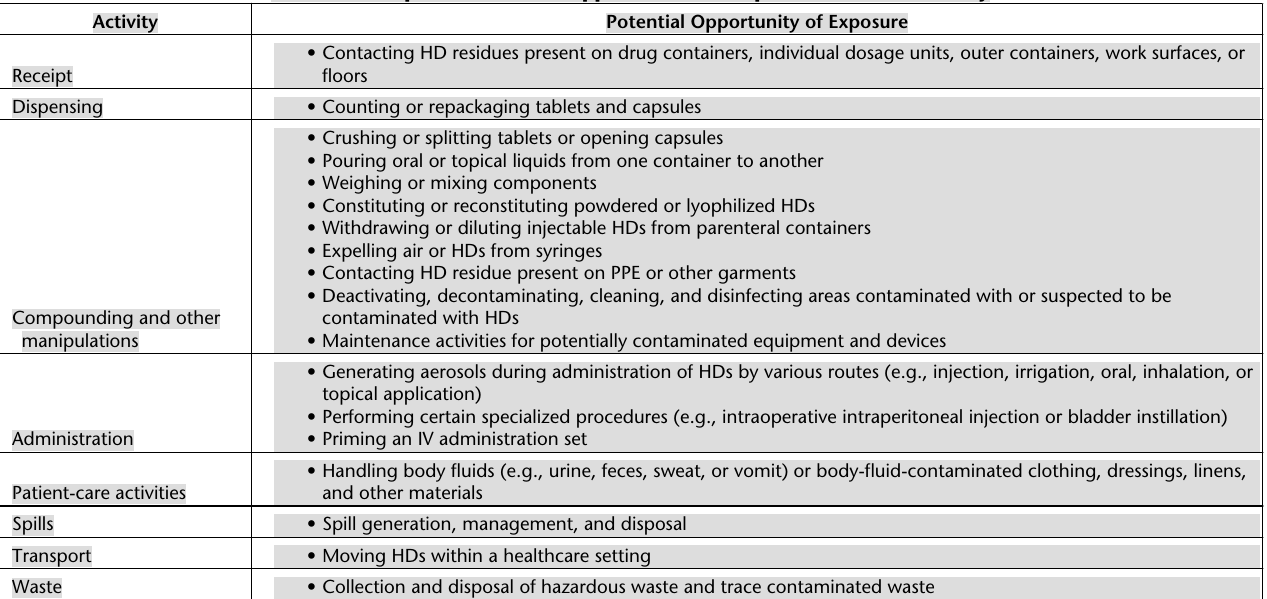
Table 1. Examples of Potential Opportunities of Exposure Based on